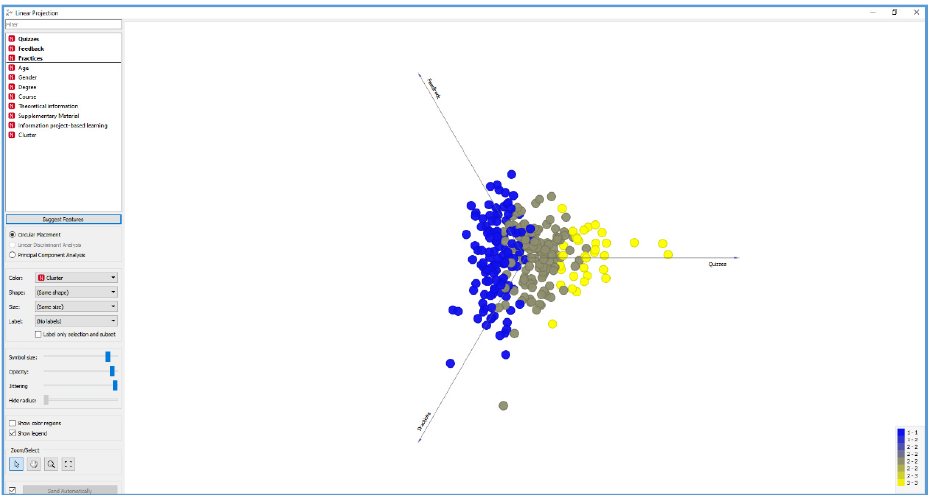
Figure 10. Visualization of the behaviour of the students of the three clusters (Cluster 1, Cluster 2, Cluster 3) for the variables with significant predictions.